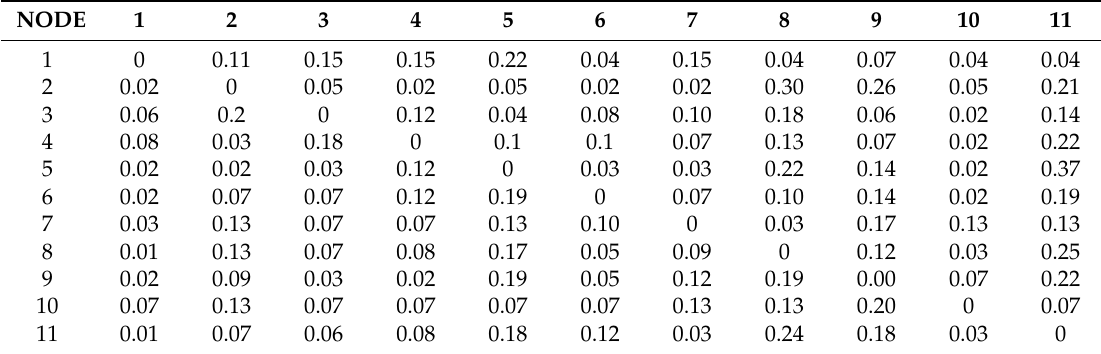
Table A2. Atletico Madrid’s matrix of state out-transition probabilities